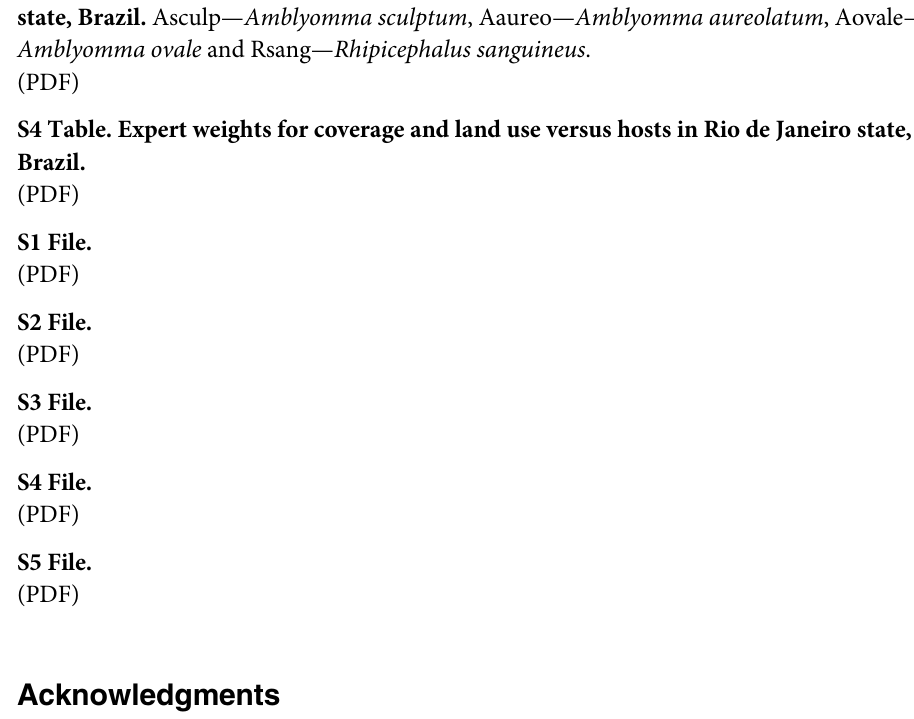
S2 Table. Final Score according to experts for the relationship of vectors and hosts with rickettsial diseases in Rio de Janeiro state, Brazil. Legend: score vh = refers to individualized ecological relationship between vector and host, score vh total = refers to the specific relation- ship between vector and transmitted disease and scale of 100. S3 Table. Expert weights for geoenvironmental domains versus vectors in Rio de Janeiro state, Brazil. Asculp— Amblyomma sculptum , Aaureo— Amblyomma aureolatum , Aovale—